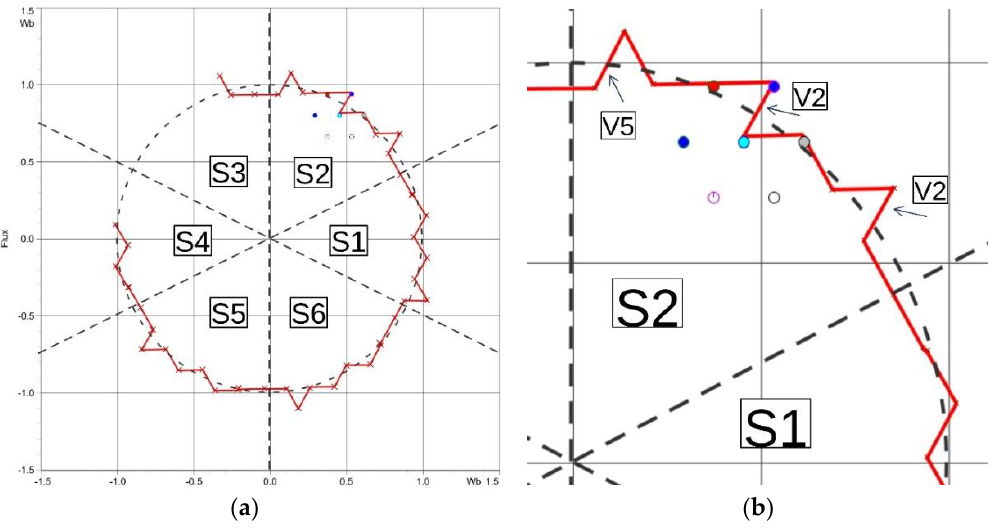
Figure 8. ( a ) The part of the flux vector tip trajectory in the PTC run. ( b ) The detail of the trajectory. Predicted effects of the vectors are displayed in the pictures. It is shown that the voltage vector V2 is selected twice and vector V5 once in sector S2. It is marked by the arrows in the figure.